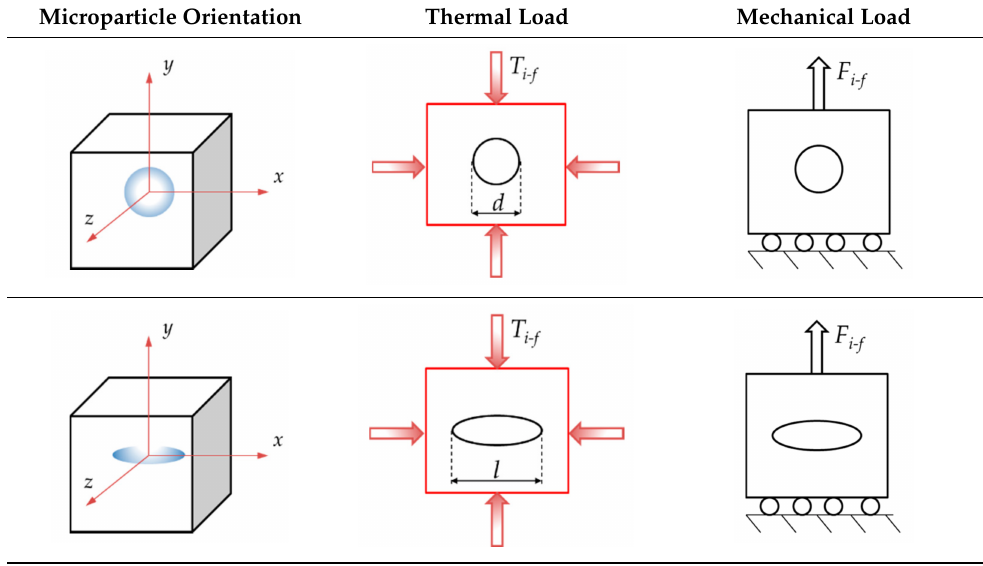
Table 1. Geometries considered for the Transient Thermal and Static